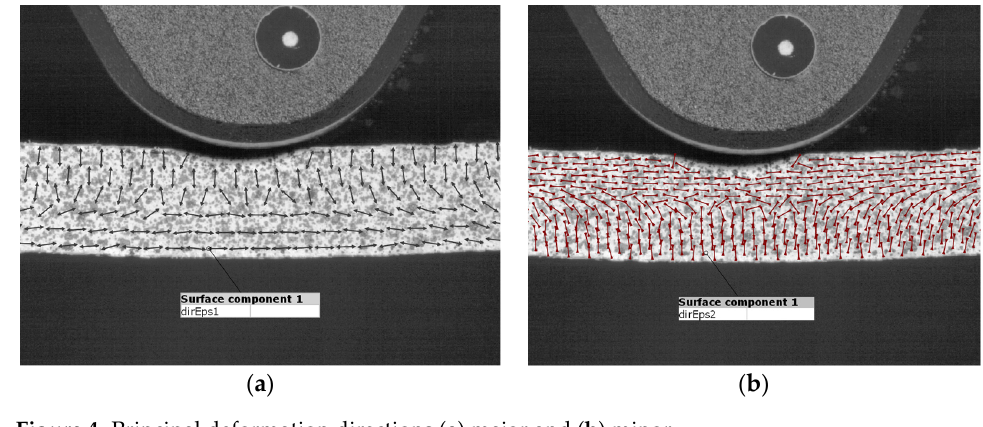
Figure 4. Principal deformation directions ( a ) major and ( b ) minor.